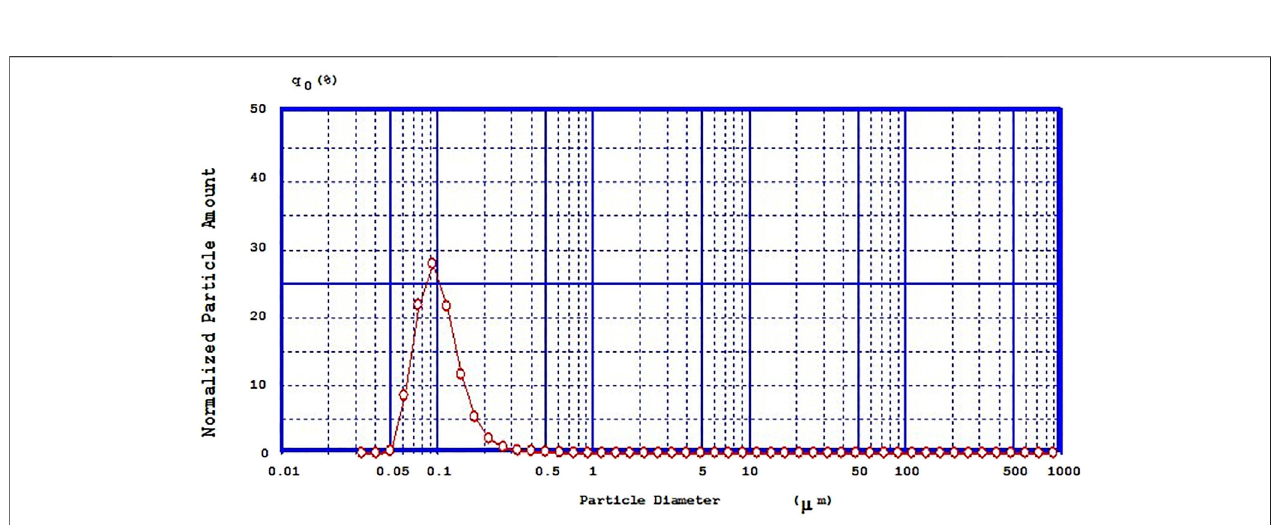
FIGURE 2 | Binary effect of different independent variables on mean particle size of NEs.